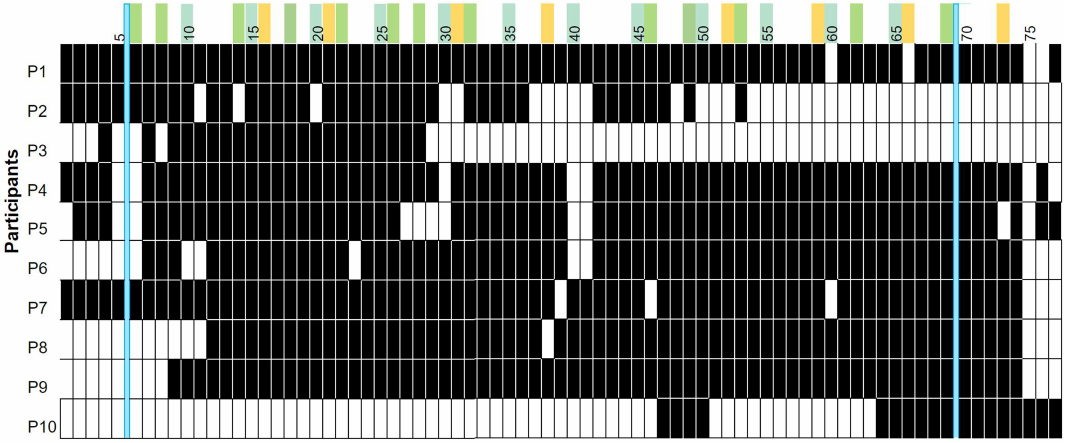
Figure 2. Utilization of activity trackers by participants per day - black = wore it, white = not wore it. The blue lines indicate first and last day of the CST. The green columns indicate days when a therapy session was held. Yellow marks are days when devices were